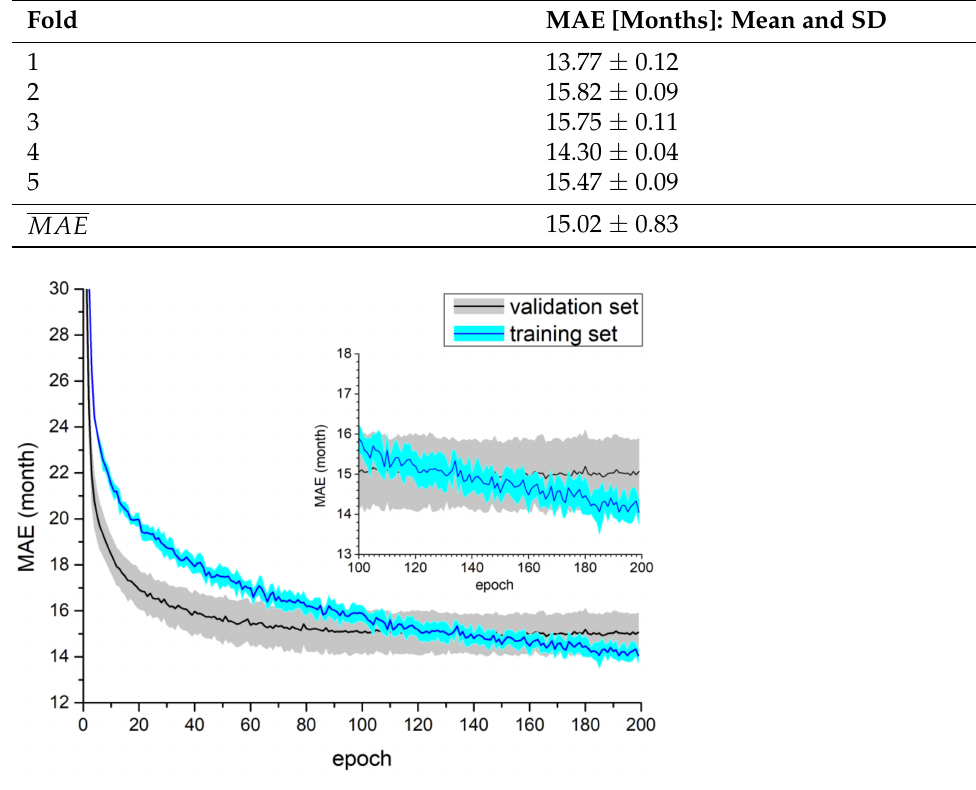
Figure 5. Training process for the MobileNetV2 DW model using the augDXA dataset. Both figures present mean and standard deviation calculated from all folds in a single test. The top right part of the figure shows the scaled part of the plot for the last 100